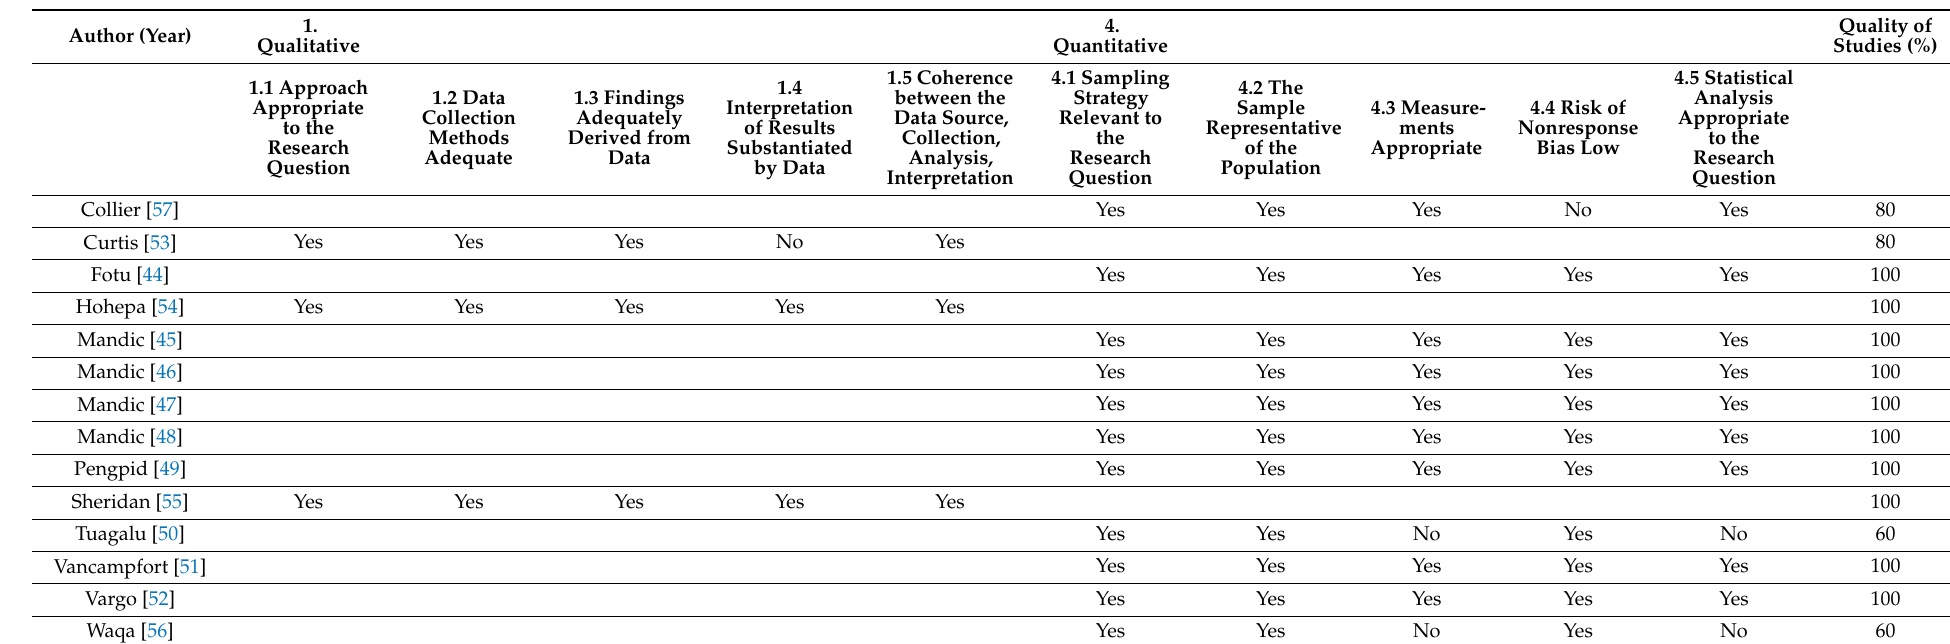
Table 2. MMAT quality appraisal